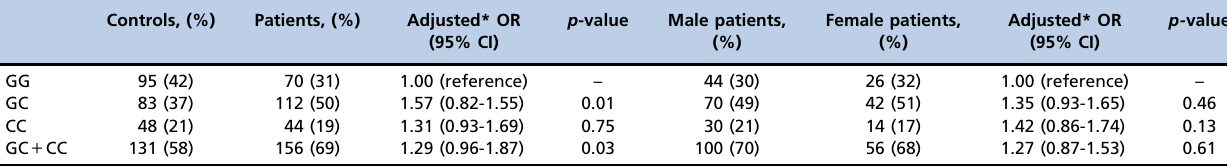
Table 2 - Association of the ERCC5 Asp1104His polymorphism with the risk of CRC. Controls, (%)